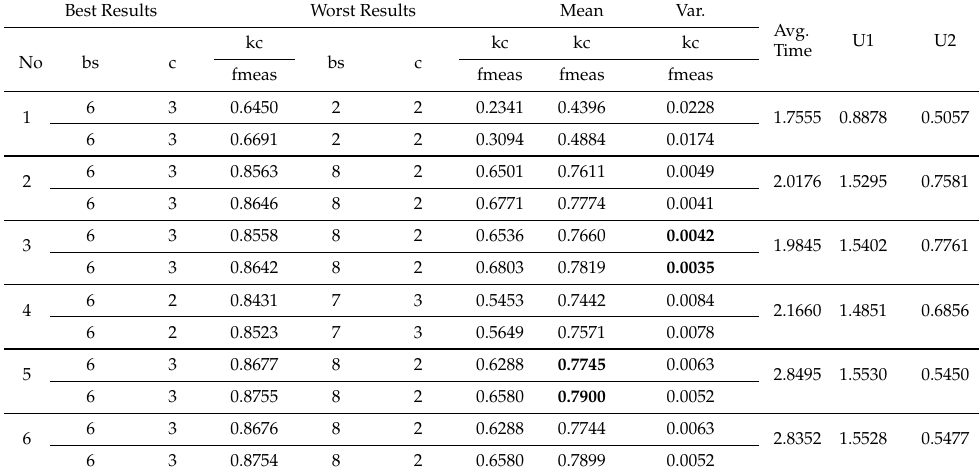
Table A5. Results of Yellow River Estuary